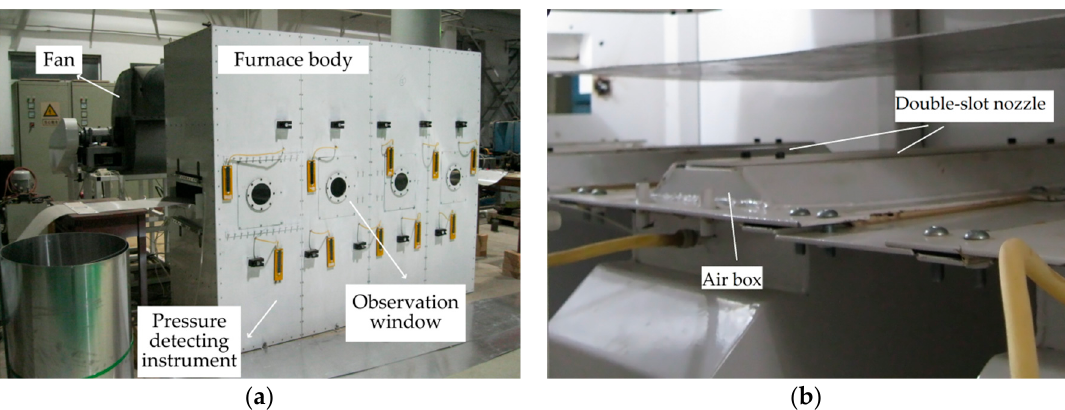
Figure 6. The schematic diagram of an air cushion furnace.